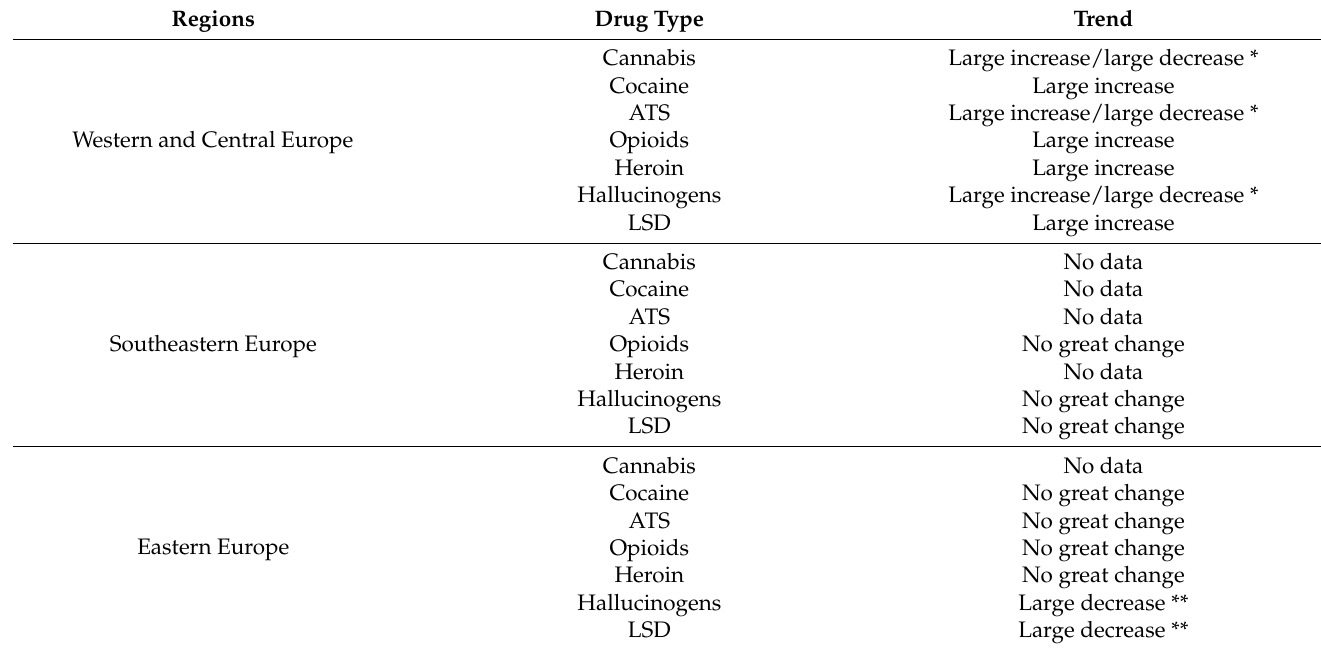
Table 1. Data trend of illicit substances use in general population for according to World Drug Report 2019: large decrease in use drug type is reported for Greece, Latvia, and Lithuania for 2019 (*); large decrease in use drug type is reported for Ukraine for 2019 (**)